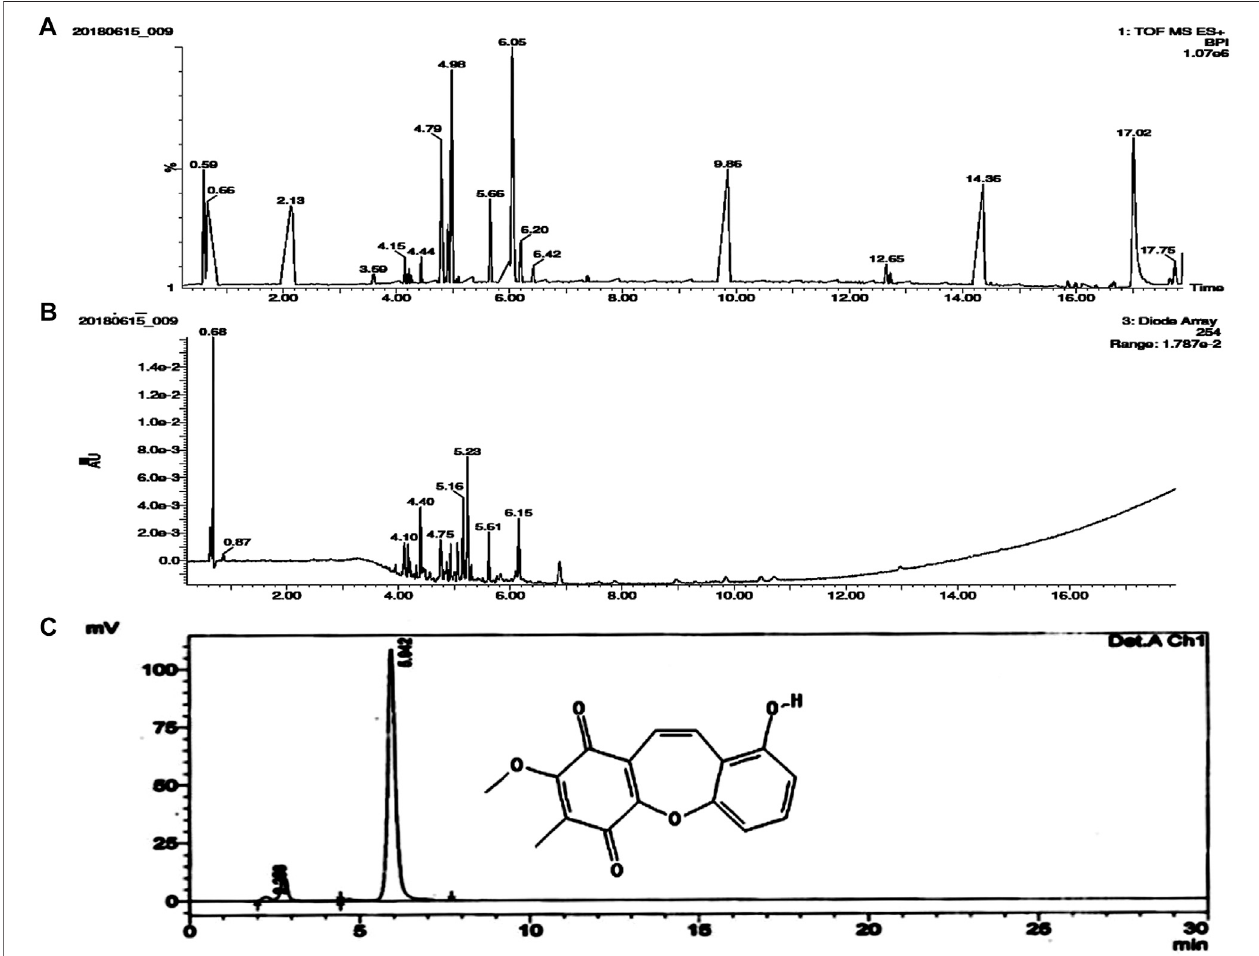
FIGURE 1 | Molecular characterization of isolated compound/s from the chloroform fraction of B. purpurea ethanolic extract. (A) and (B) LC-MS analysis showing TOF MS ES + BPI and Diode Array (Retention Time) (C) HPLC peak representing structure and retention time (5.942) of BSTN1.